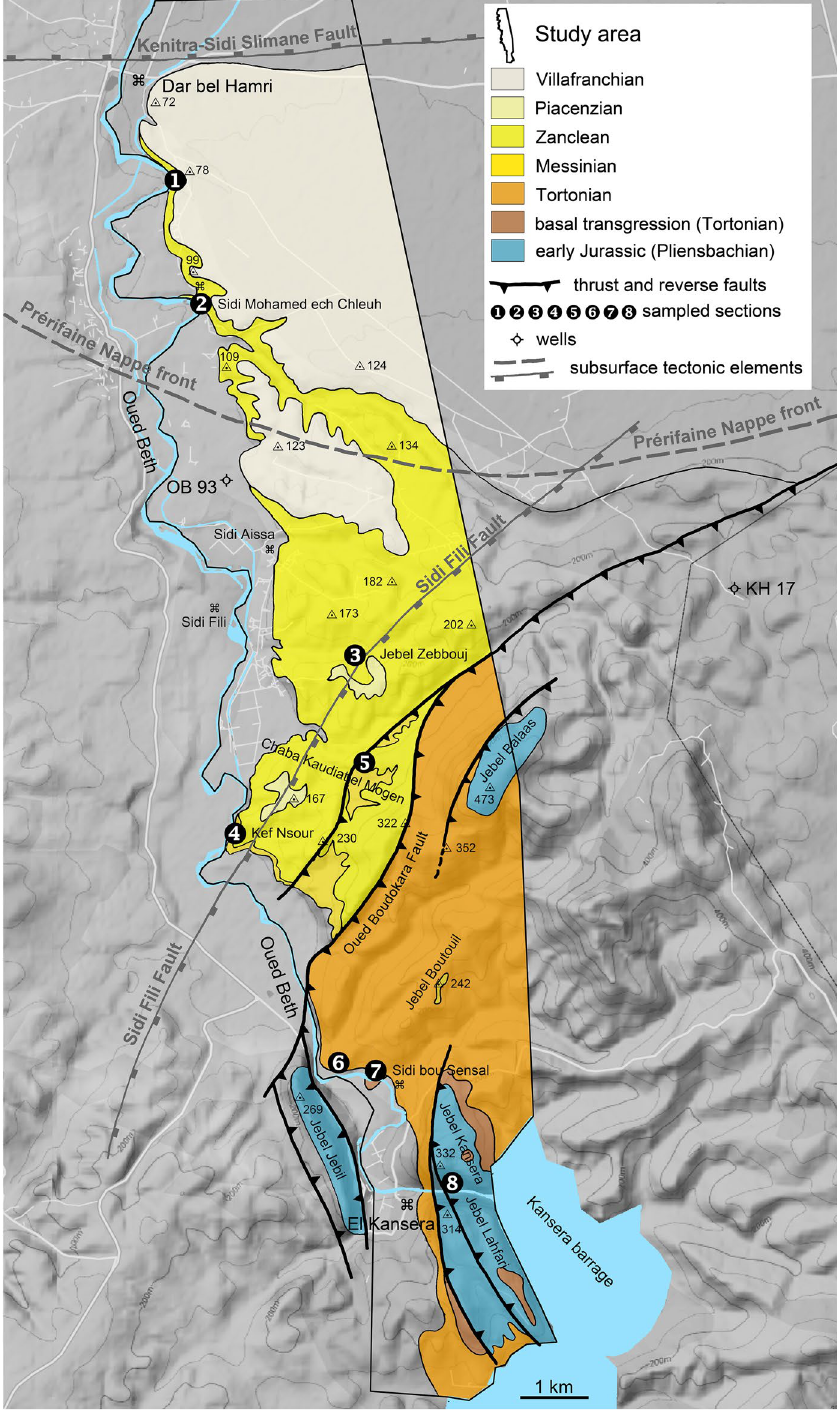
Fig. 2 Geological map of the studied area from Dar bel Hamri to El Kansera resulting from a review of my master thesis (1977), and highlighting sections sampled. The location of the subsurface Sidi Fili fault and Nappe Prérifaine front are extrapolated from Tilloy (1952) and the postulated extension of the Kenitra-Sidi Slimane fault is from Zouhri et al.